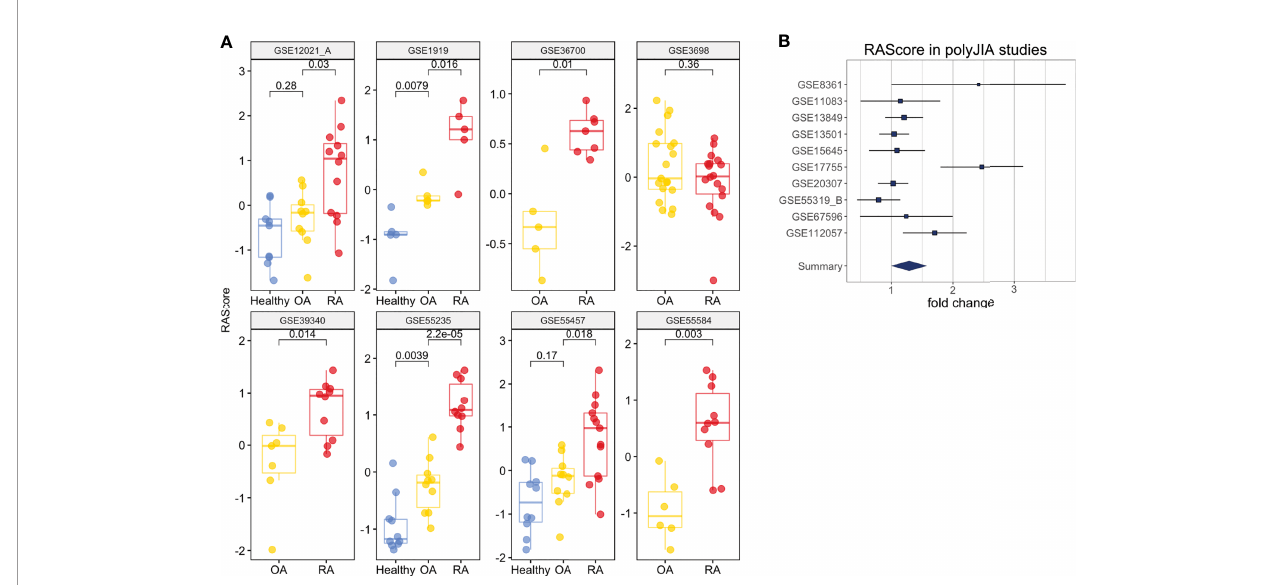
FIGURE 5 | Clinical Interpretation of the RA Score. (A) The RA Score distinguishes Healthy, OA and RA samples in synovium. (B) The RA Score distinguishes Healthy and polyJIA samples. The p-values were obtained using Student ’ s